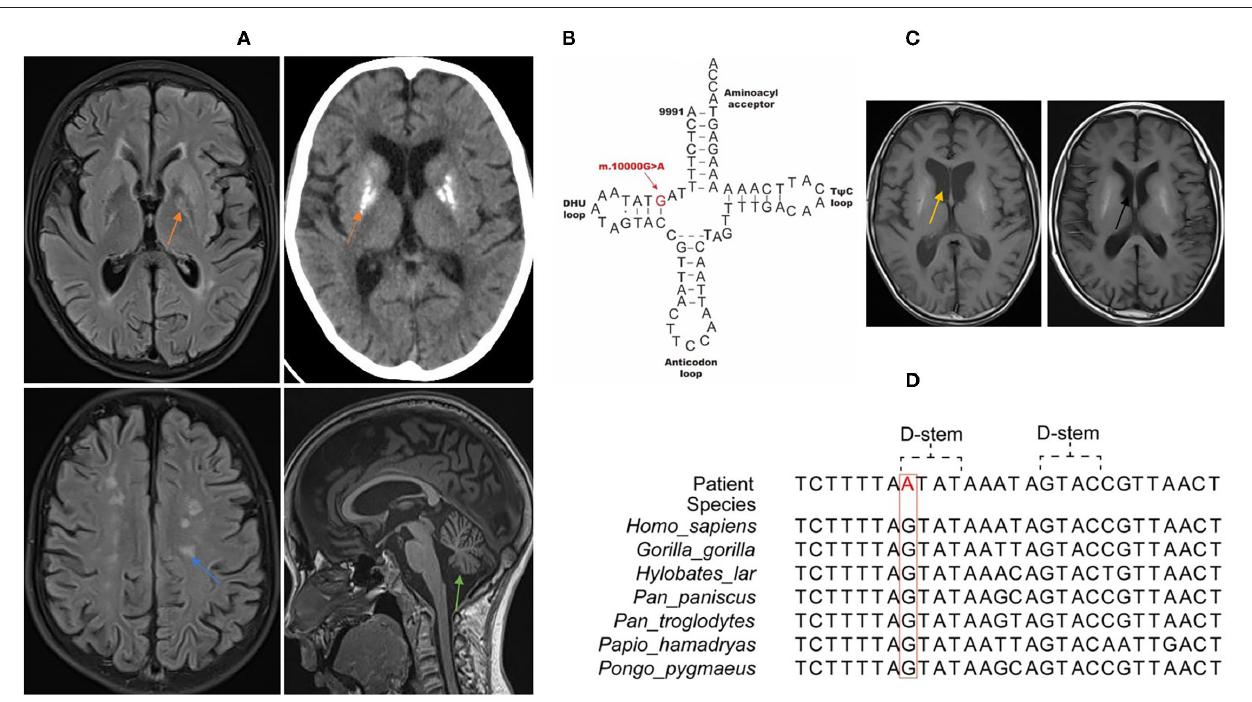
FIGURE 1 | Clinical features and genome profiling reveal a highly conserved, rare, and likely pathogenic de novo variant (m.10000G > A) of MT-TG in the 13-year-old patient. (A) Brain MRI/CT of the patient. The orange arrow shows basal ganglia calcification. The blue arrow shows multiple lesions in the white matter. The green arrow shows brain stem and cerebellum atrophy. (B) Schematic representation of the mitochondrial tRNA Val clover leaf structure and the corresponding location of the novel variation (marked in red) that is confirmed to be a likely pathogenic mt-tRNA Val variant. (C) Brain MRI shows that brain atrophy was improved and that the enlarged ventricle seen in previous MRI returned to normal. The yellow arrow shows the enlarged ventricle in acute stage. The black arrow shows the normal ventricle 1 month later after cocktail therapy. (D) Phylogenetic conservation of the appropriate regions of multiple mt-tRNA Val gene sequences for m.10000G > A. The highlighted residue is conserved across all the